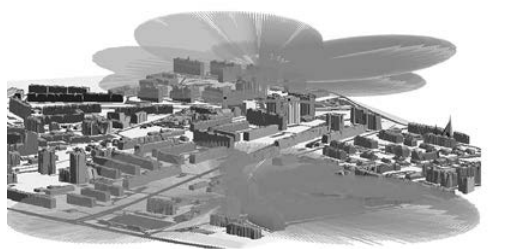
Fig. 5. Rays of radio wave propagation generated by antennas